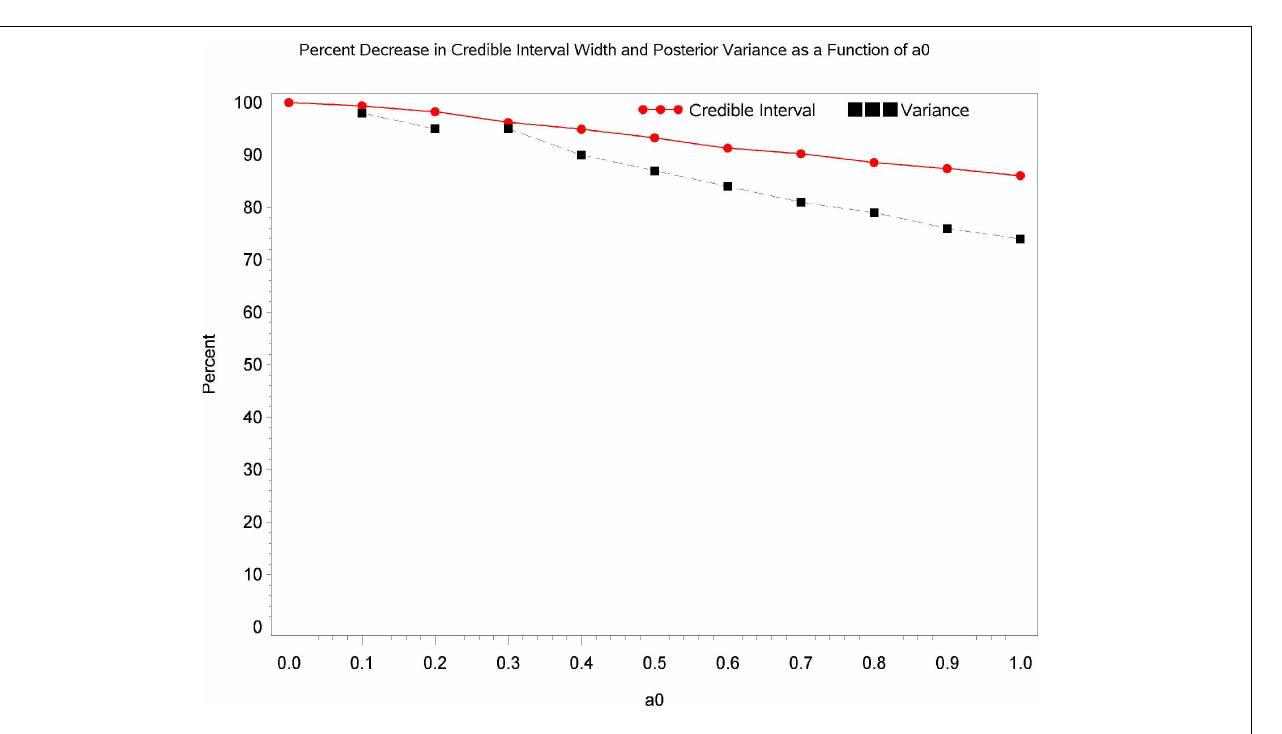
function of altering a 0 .The blue line shows the magnitude of the decrease in the variance of the posterior distribution as a